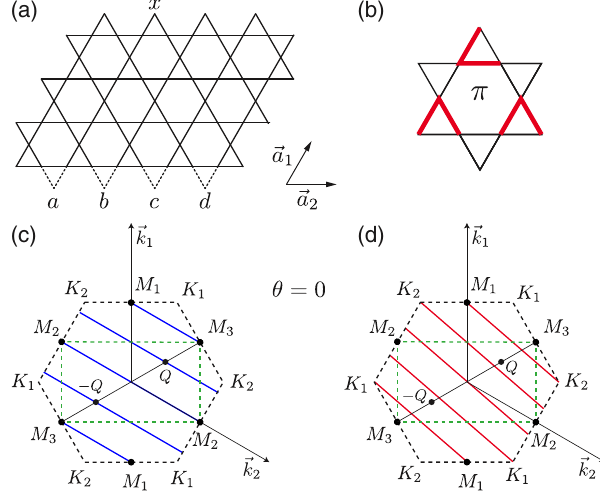
FIG. 1. (a) Illustration of the kagome lattice with a width of L ¼ 4 unit cells. The different geometries, YC8-0, YC8-2, YC8- y 4, and YC8-6, correspond to identifying the site x with the site a , b , c , or d , respectively. (b) The π -flux state, where each hexagon has π flux. We chose a specific gauge, in which the red bond has s ¼ − 1 , and the black bond has s ¼ 1 . The different geom- ij ij etries [here (c) YC8-0 and (d) YC8-2] correspond to different ways of cutting the Brillouin zone (shown as blue and red lines). The M points are [labeled by ð k 1 ; k 2 Þ ], M 1 ¼ ð π ; 0 Þ , M 2 ¼ ð 0 ; π Þ , and M 3 ¼ ð π ; π Þ . The DSL has a halved magnetic Brillouin zone (dashed line) because it is a π -flux ansatz. The two Dirac points of the DSL are at (cid:2) Q , and we refer to this as Q , Q 0 in the text. Note the blue and red lines represent cuts in the original Brillouin zone; the allowed momenta of the fractionalized spinons form similar cuts through the magnetic Brillouin zone, but the cuts are displaced according to the spin flux θ and the emergent gauge flux ϕ , as we explain in Sec. III